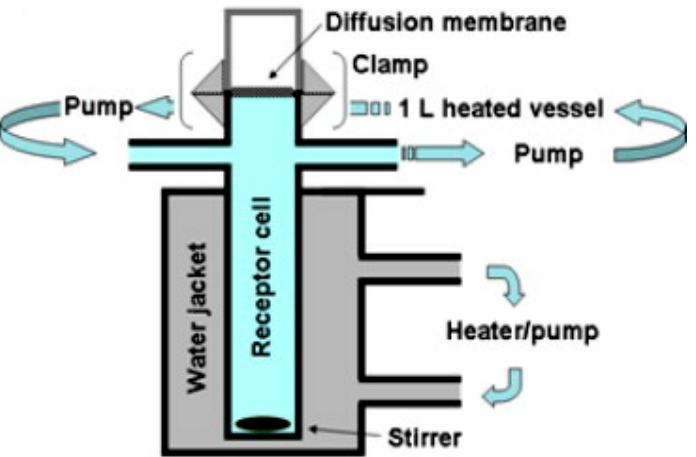
Figure 7. Schematic representation of the Franz diffusion cell (the figure is taken from reference [14]).